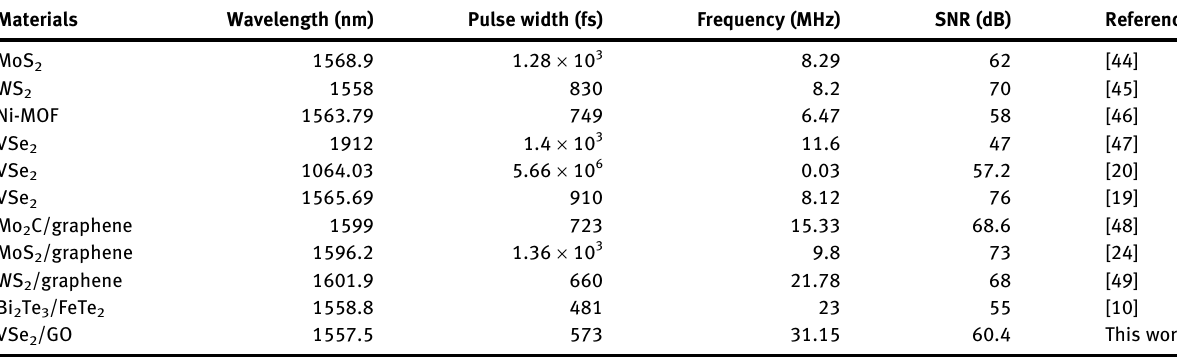
Table  : Output results of the fi ber lasers based on different  D material SAs. Materials